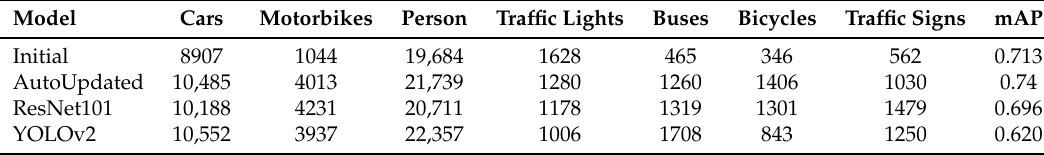
Table 2. Number of objects detected in real-life video across all experiments.